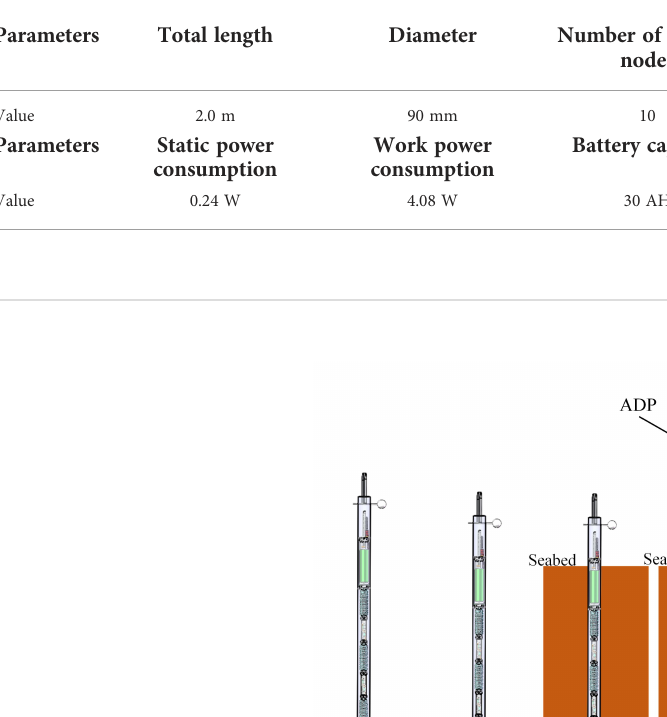
TABLE 1 The speci fi cations of the monitoring